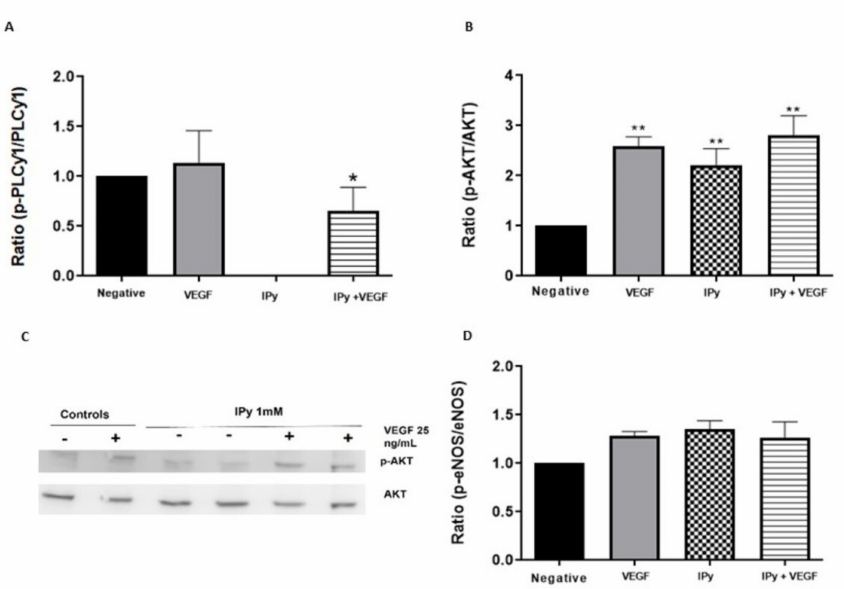
Figure 3. Indole pyruvic acid inhibits PLC γ 1 phosphorylation while activate Akt and eNOS. HUVEC cells were treated with IPy (1 mM) for 4 h and then stimulated with VEGF (25 ng/mL) for 10 min ( A ) and 60 min ( B – D ). Western-blot membranes were incubated with anti PLC γ -1 and anti p-PLC γ -1 ( A ), anti Akt and anti p-Akt ( B , C ) and anti eNOS and anti p-eNOS ( D ) antibodies. Data representation of phosphorylated antibody/total antibody ratio is indicated as mean ± SD ( n = 5). * p < 0.05, ** p < 0.01 against VEGF alone ( A ) and versus negative control ( B